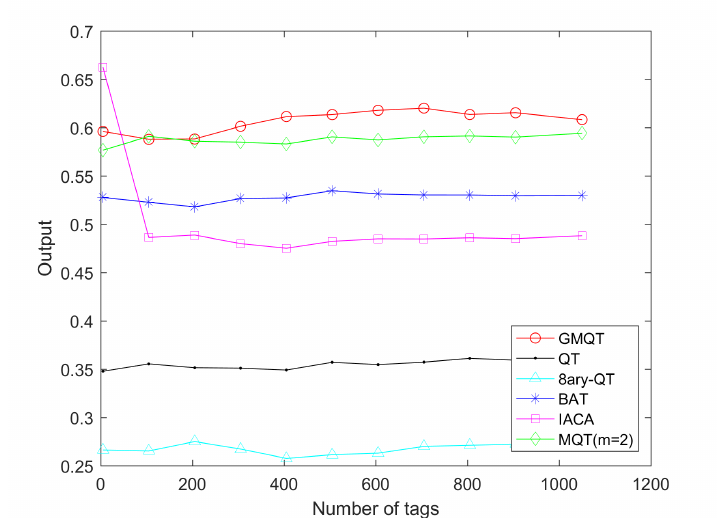
Figure 3. System efficiency with different